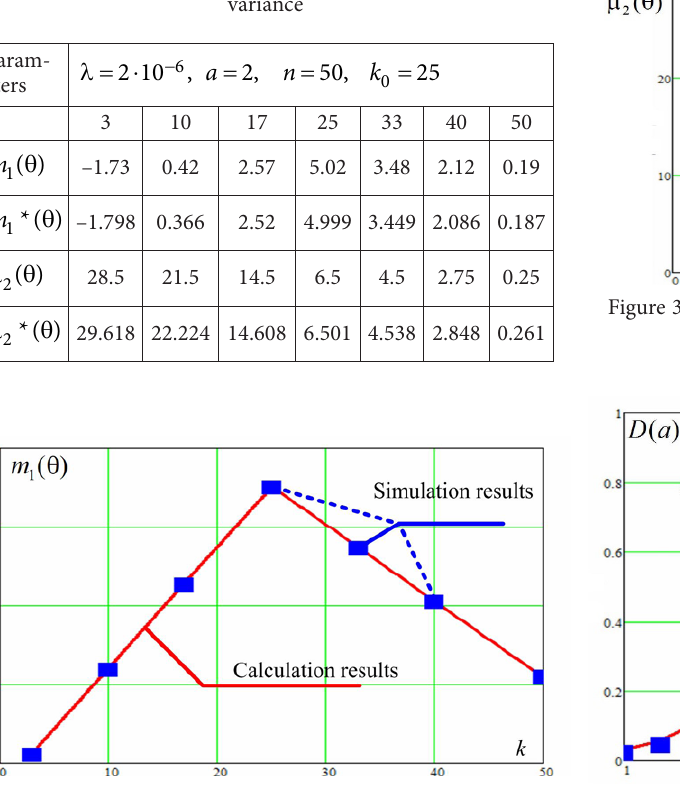
Figure 2. Dependence of the mathematical expectation of decisive statistics θ on parameter k according to the data of Table 1